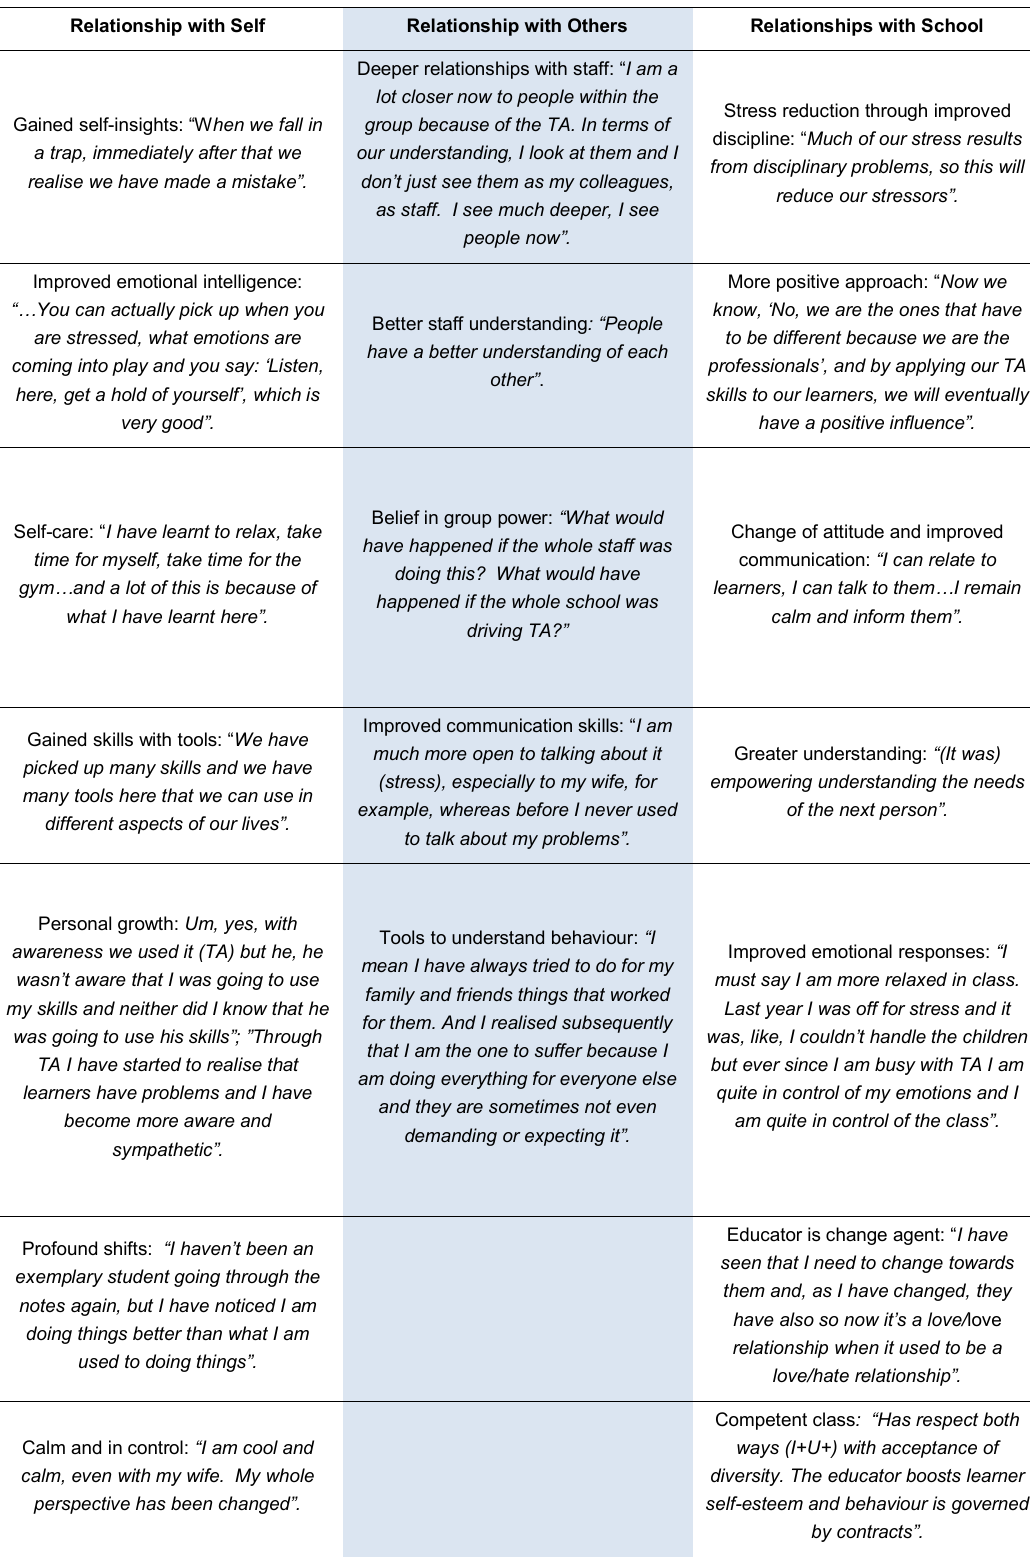
Table 4: Summary of TA Dominant